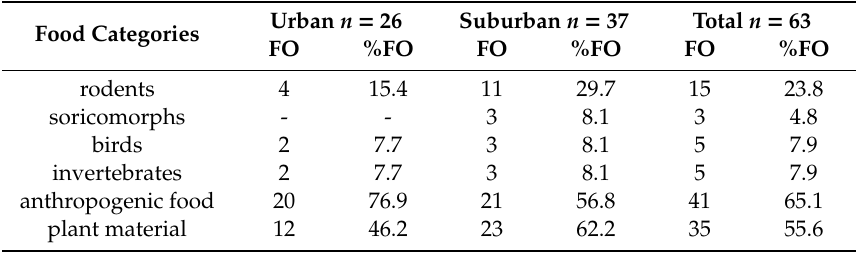
Table 3. Food categories in cats’ diet based on examined stomachs. n —number of stomachs with content, FO—number of stomachs containing food